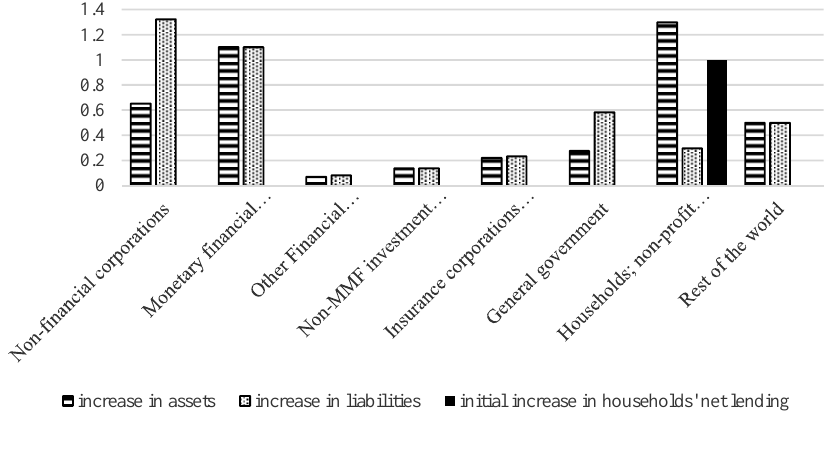
Figure 7. The effects of the increase in excess of financial assets over liabilities of households — net lending — by 1 million PLN